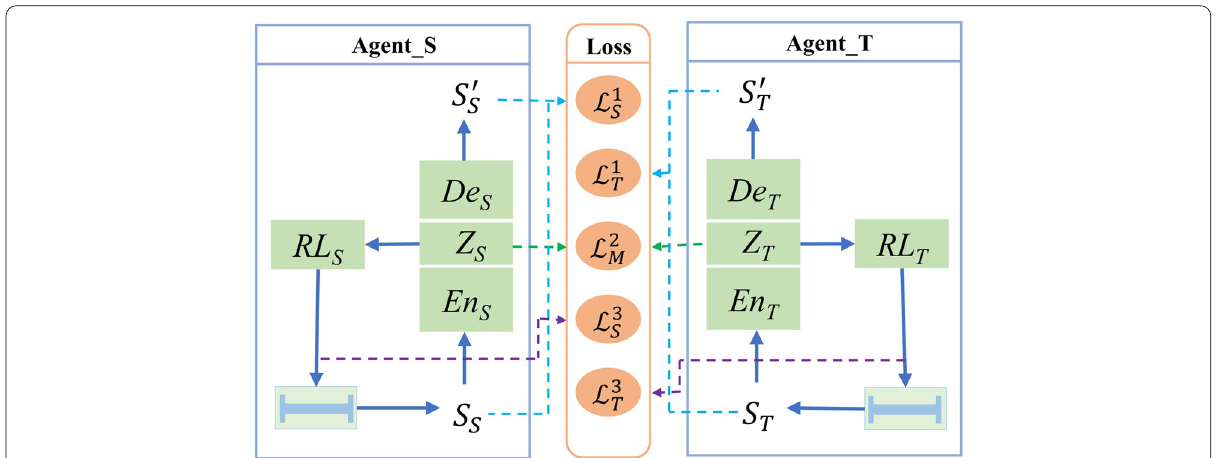
Fig. 4 Base model with two subnetworks. Each subnetwork has an autoencoder and a reinforcement learning